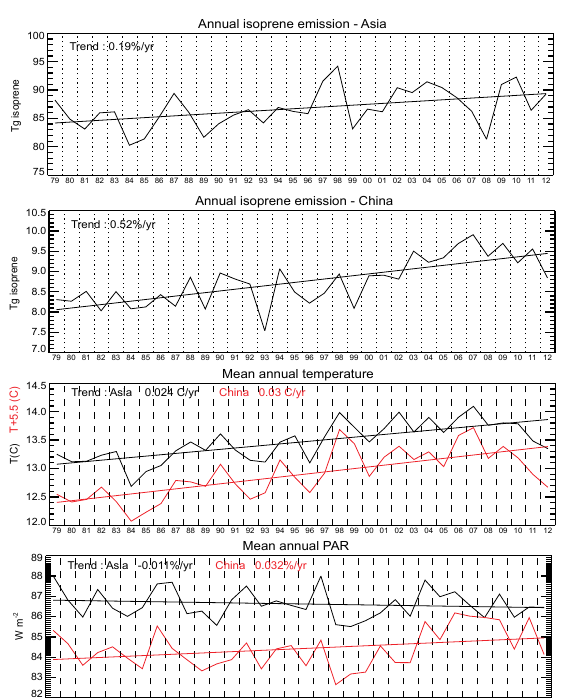
Fig. 6. Annual isoprene emissions (Tg) in the whole domain, and China (two upper panels) over 1979–2012 using the S0 simulation. Annual temperature and PAR (bottom) in Asia (black) and China (red) are shown in the two lower panels over the same period. Linear regression trends are given inset and applied over the whole simu- lation period.